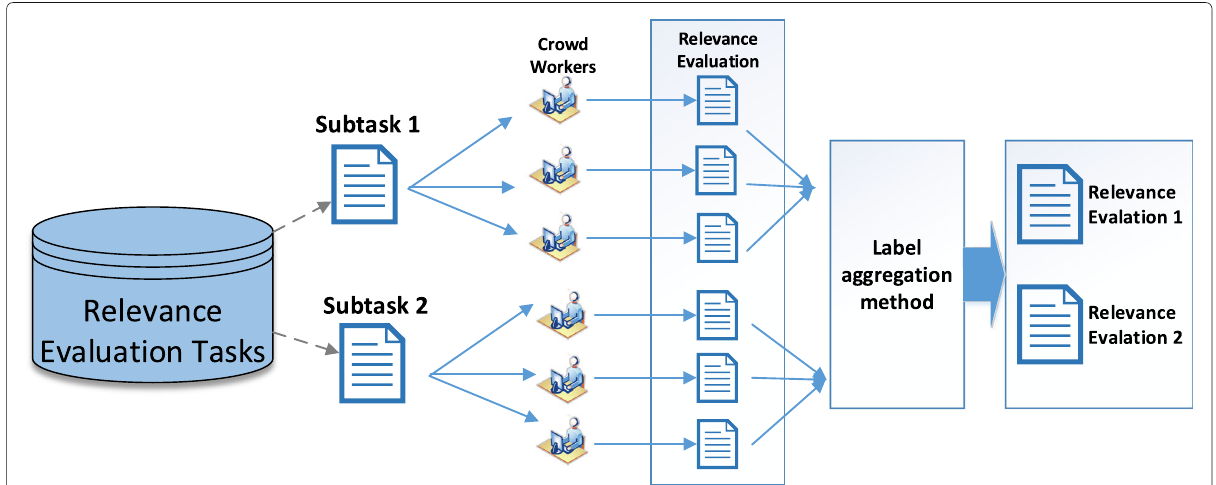
Fig. 1 Relevance evaluation. The processes of relevance evaluation tasks with crowd-workers